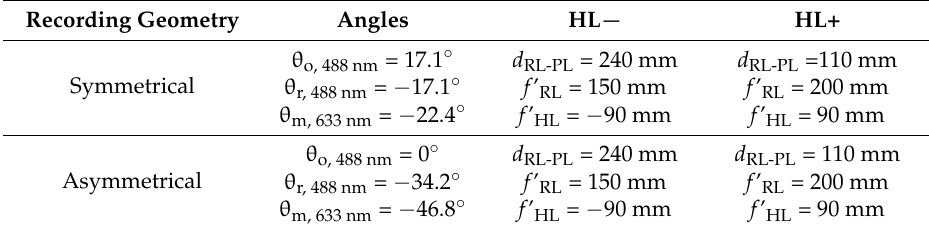
Table 1. Recording parameters of the holographic lense